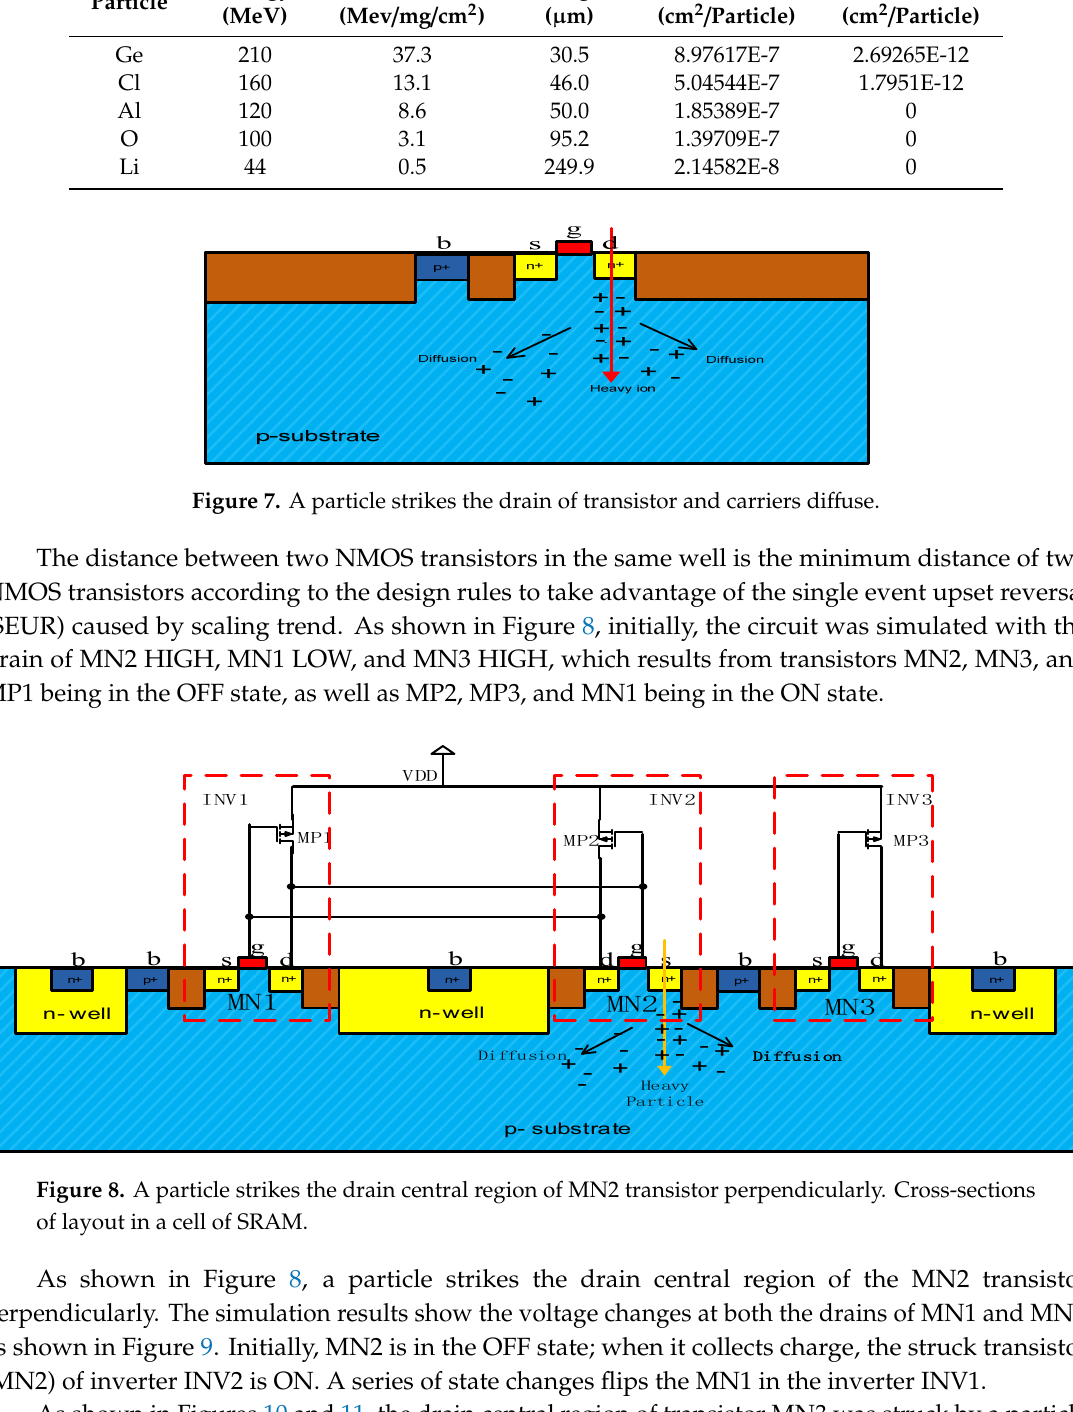
Figure 9. Drain voltages of MN1 and MN2 when the drain of MN2 is struck by a particle.